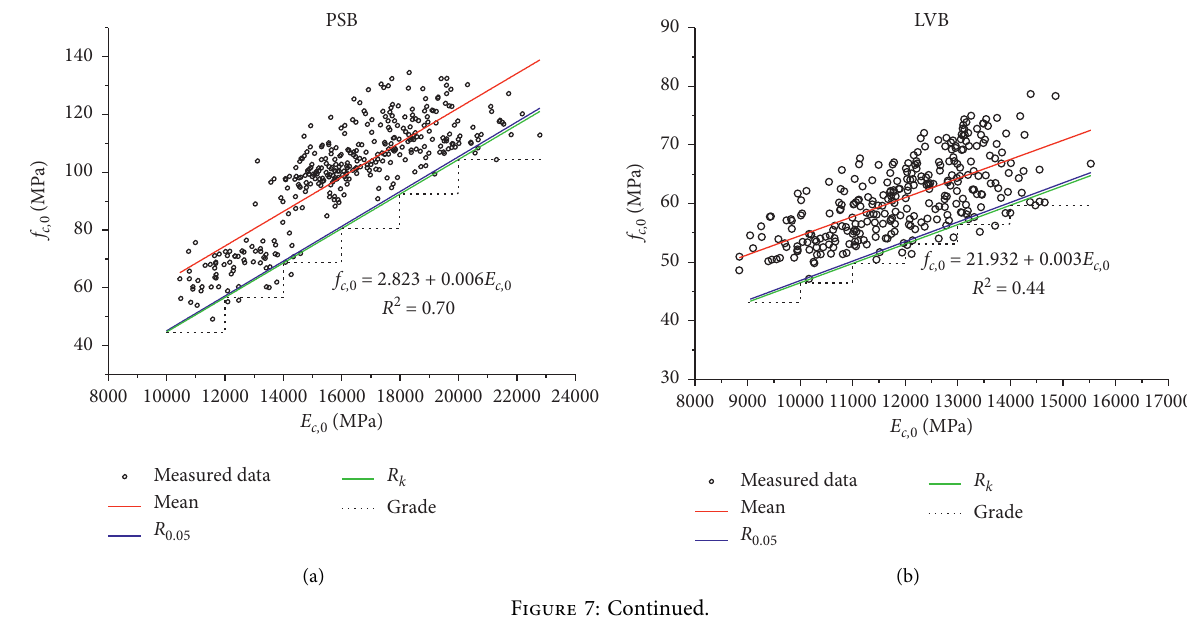
Figure 6: Ellipse band and predicted band analysis of linear regression: f for PSB (c); f c ,0 against ρ for LVB